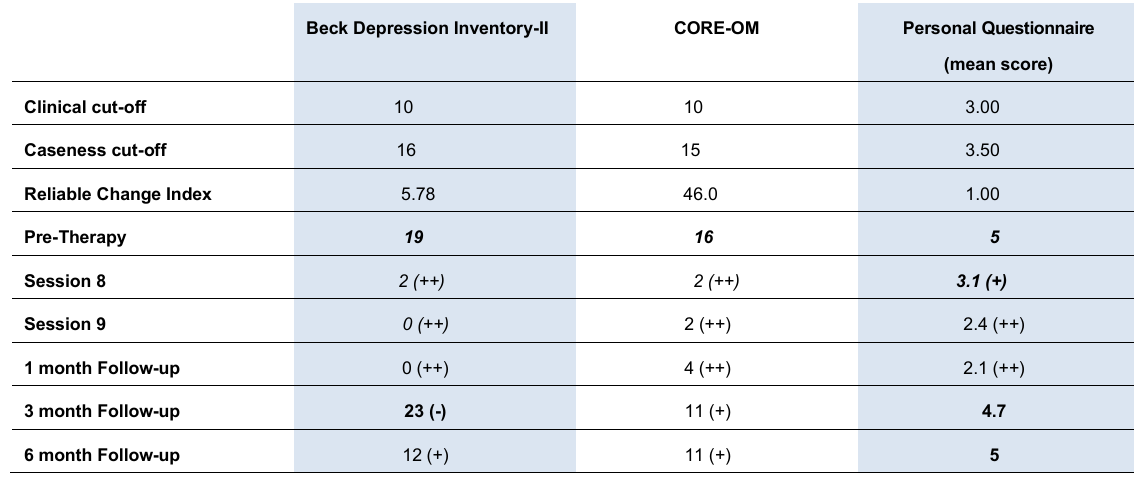
Table 1: Linda’s Quantitative Outcome Data